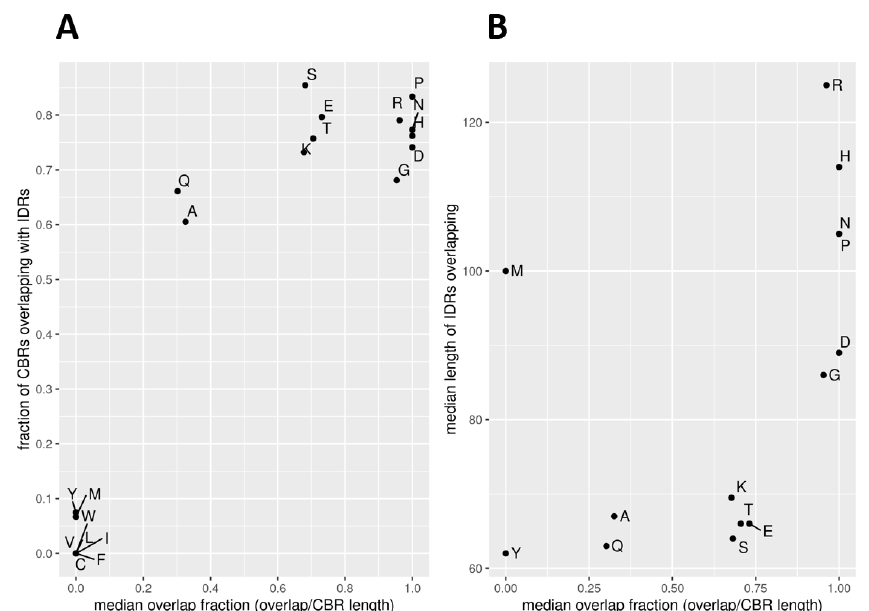
Figure 3. Extent of overlap of CBRs to IDRs by CBR type. ( A ) Fraction of CBRs that overlap any IDR (predicted with IUPred) versus the median fraction of the overlap relative to the total size of the CBR (0.5 means that half of the CBR overlaps an IDR). ( B ) Median length (residues) of overlapping IDRs versus the median fraction of the overlap relative to the total size of the CBR.